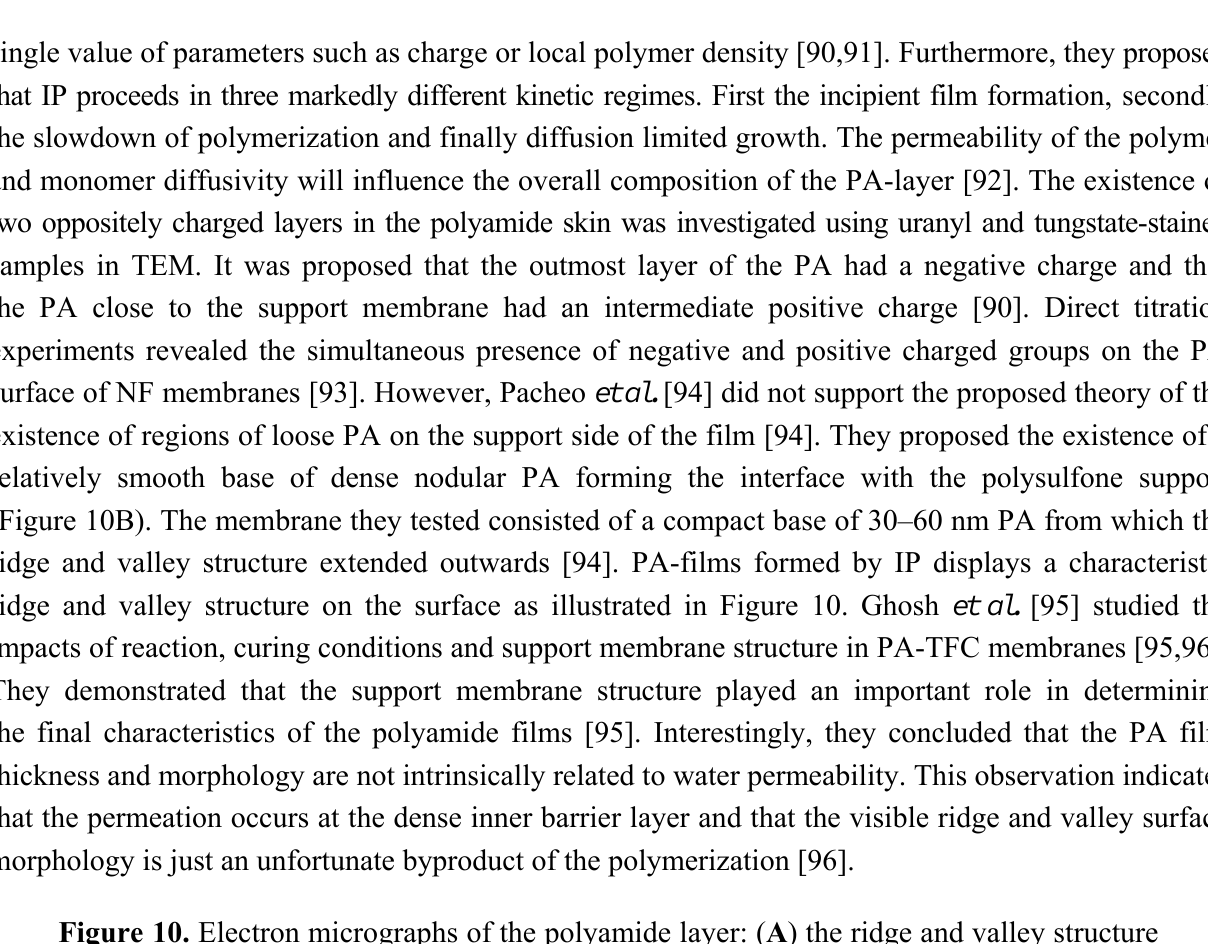
Figure 10. Electron micrographs of the polyamide layer: ( A ) the ridge and valley structure of the PA surface, micrograph from [94]; ( B ) TEM cross section of an isolated PA-layer, micrograph from [96]; ( C ) SEM cross section an on TFC membrane, micrograph from